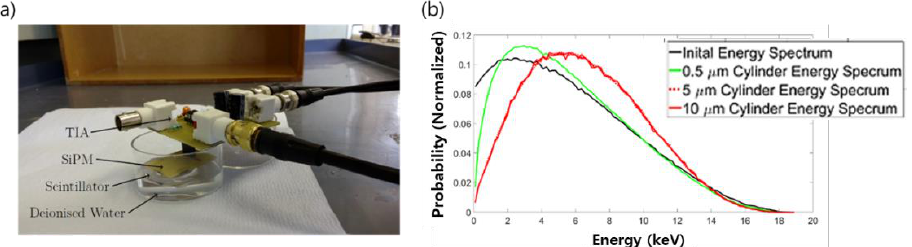
Figure 7. Tritium detection system using the CaF 2 :Eu scintillator and the Preamp(TIA), SiPM ( a ) and energy spectrum according to tritium cylinder thickness ( b ) [28].